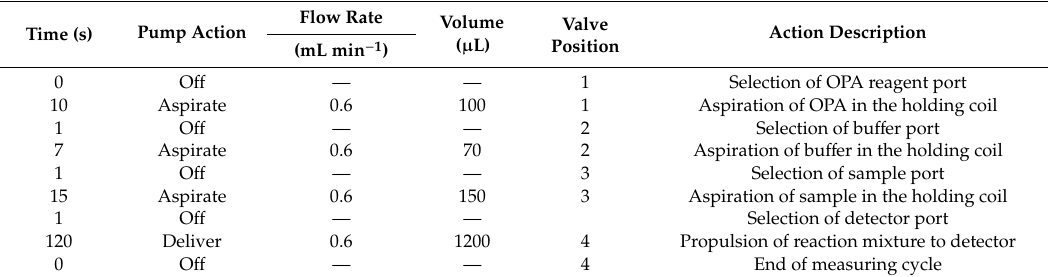
Table 1. ZF steps for the determination of GSH.